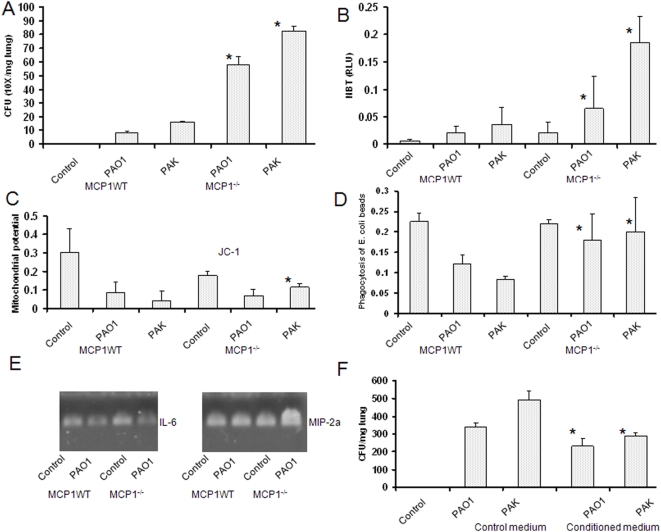
MCP-1−/− mice demonstrated functional involvement with P. aeruginosa infection.(A) MCP-1−/− mice showed more severe infection by P. aeruginosa (strains PAO1 and PAK) with an increase in bacterial burdens. Data were derived from a group of 5 infected and control mice (same in the figure). (B) Superoxide production was significantly altered in AM from MCP-1−/− mice following infection identified by NBT assay. (C) A significant increase in apoptotic cell death was observed in MCP-1−/− mice by bacterial infection. The data identified the loss of mitochondrial potential in MCP knockout mice, indicating increased cell apoptosis. (D) An increase opsonic phagocytosis with E. coli particles was found in AM derived from MCP-1−/− mice following infection. (E) An increase in inflammatory chemokine MIP-2α in the MCP-1−/− mice after PAO1 infection. The mRNA expression is shown in an agarose gel using semi-quantitative RT-PCR. (F) Conditioned medium partially restored the immune defense against P. aeruginosa infection in MCP-1−/− mice. Statistical analysis was as above. The results are representative of two experiments.